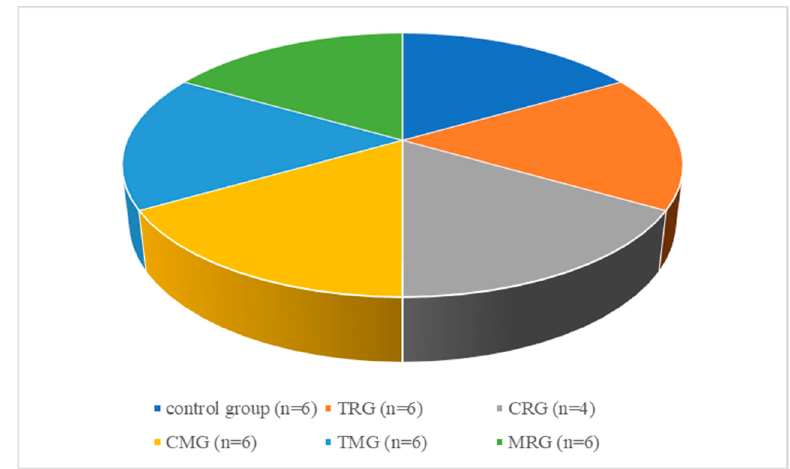
Figure 1. Drug protocols used in the current experiment.